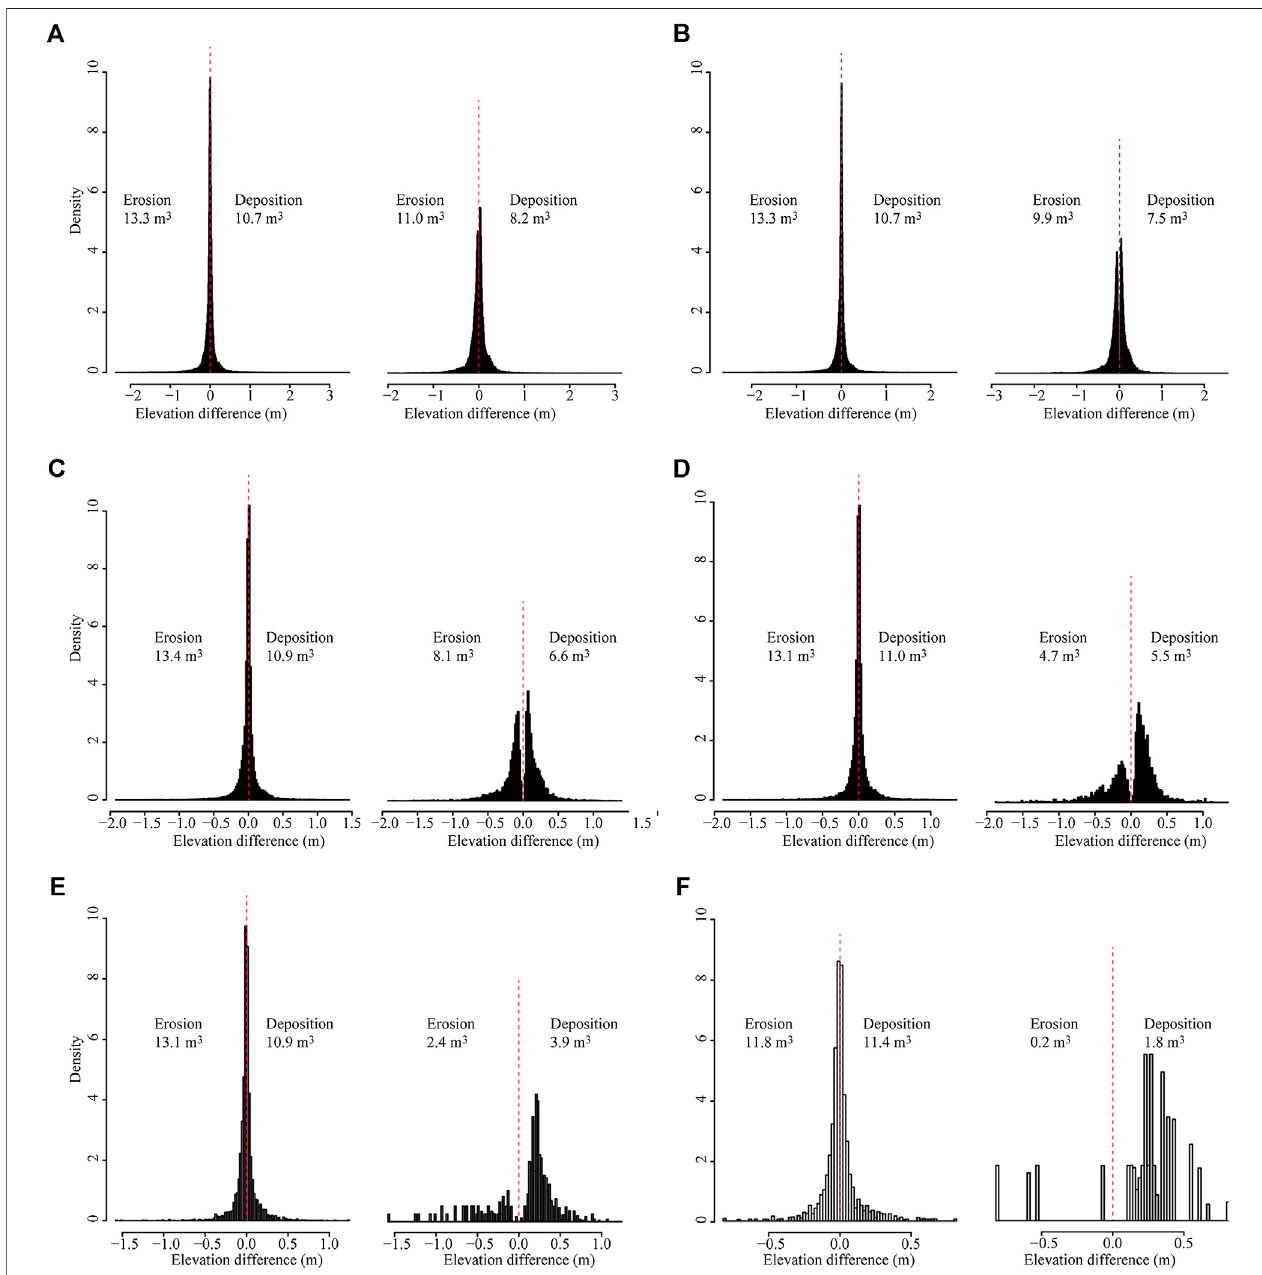
FIGURE 6 | Histograms of the elevation difference representing erosion (negative elevation difference) and deposition (positive elevation difference) for different DEM resolutions: (A) 2-cm, (B) 4-cm, (C) 8-cm, (D) 16-cm, (E) 32-cm, and (F) 64-cm. The left histogram in each panel is for the direct DEM differencing without the consideration of errors. The right histogram in each panel is for the DoD analysis with the consideration of the propagated error based on Eq. 3 .